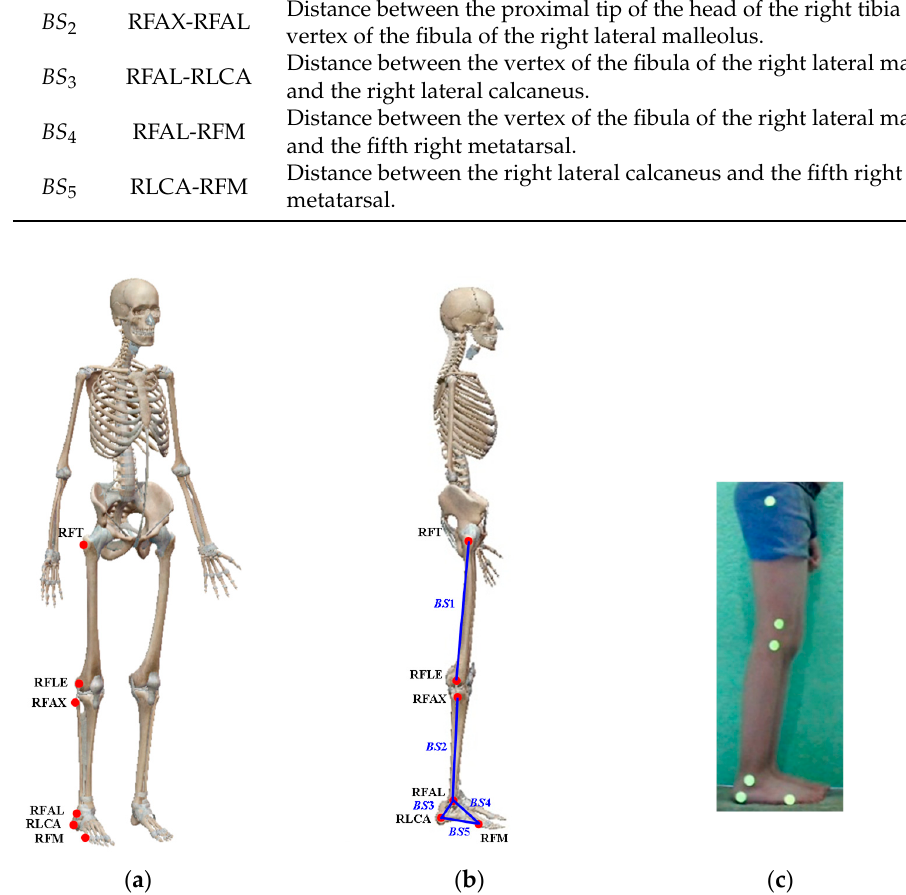
Figure 2. Markers protocol: ( a ) definition of the bone landmarks, ( b ) definition of the body segments, and ( c ) placing the markers on the participant. Table 1. Definition of the bone landmarks.